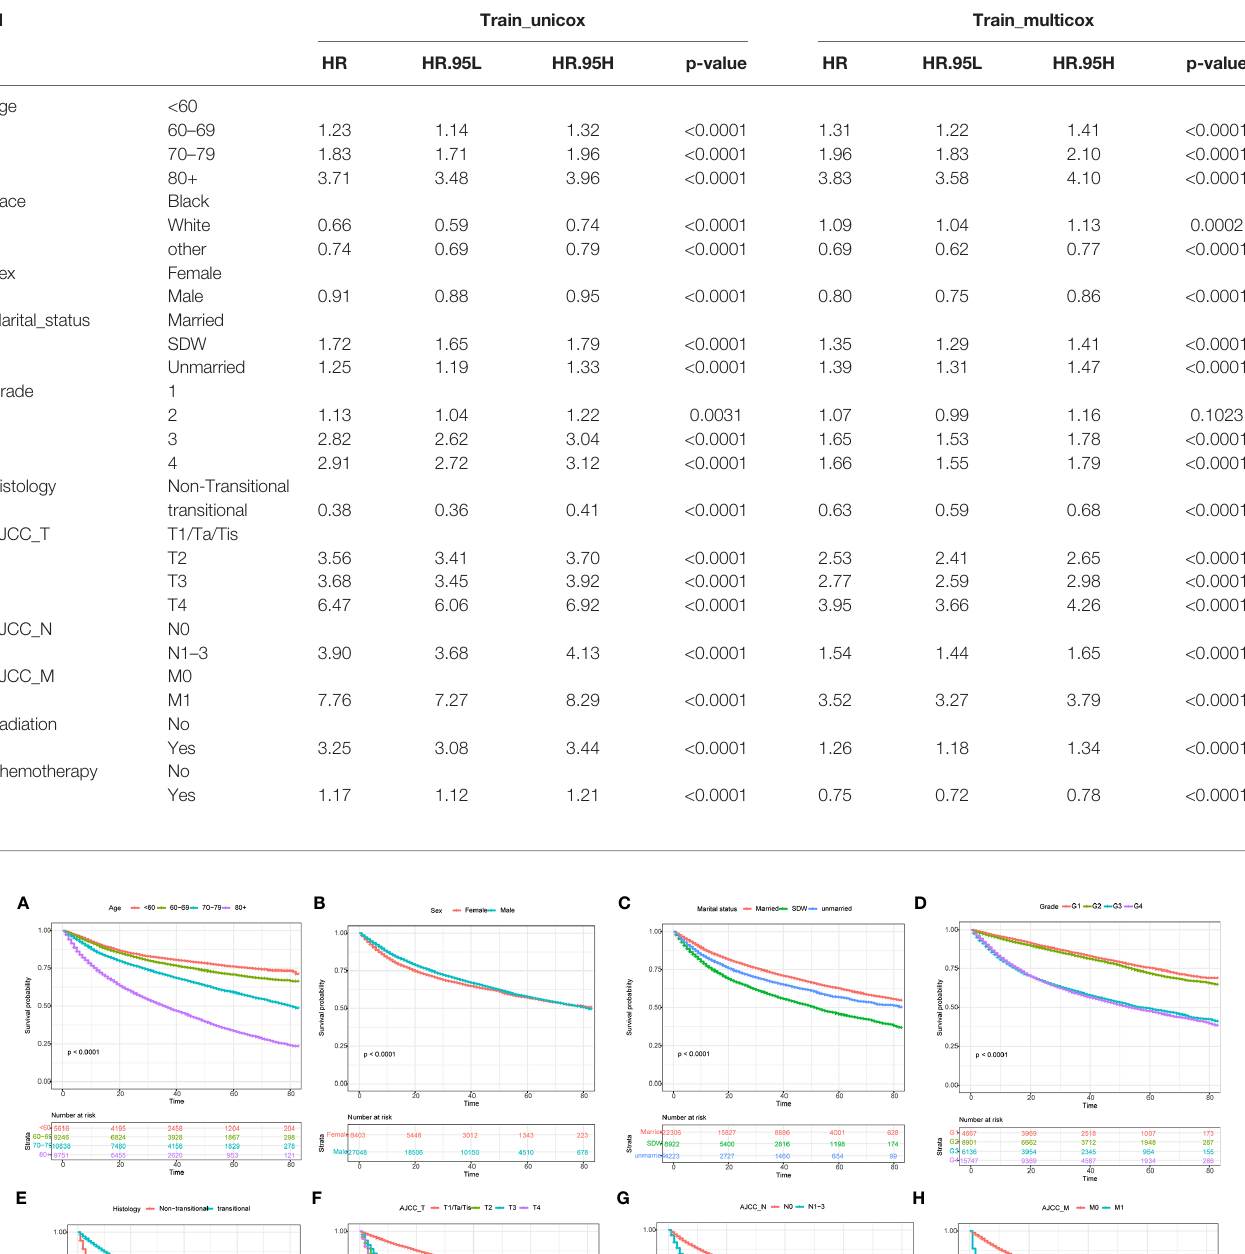
TABLE 2 | Results of univariate and multivariate Cox regression using the training set.